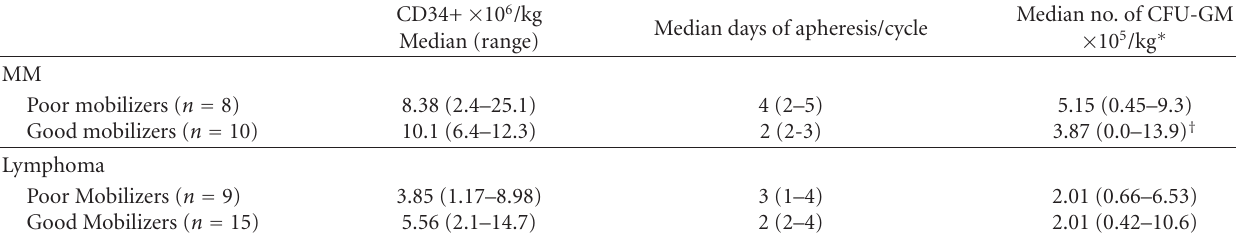
Table 4: Summary of apheresis yields in the di ff erent groups of